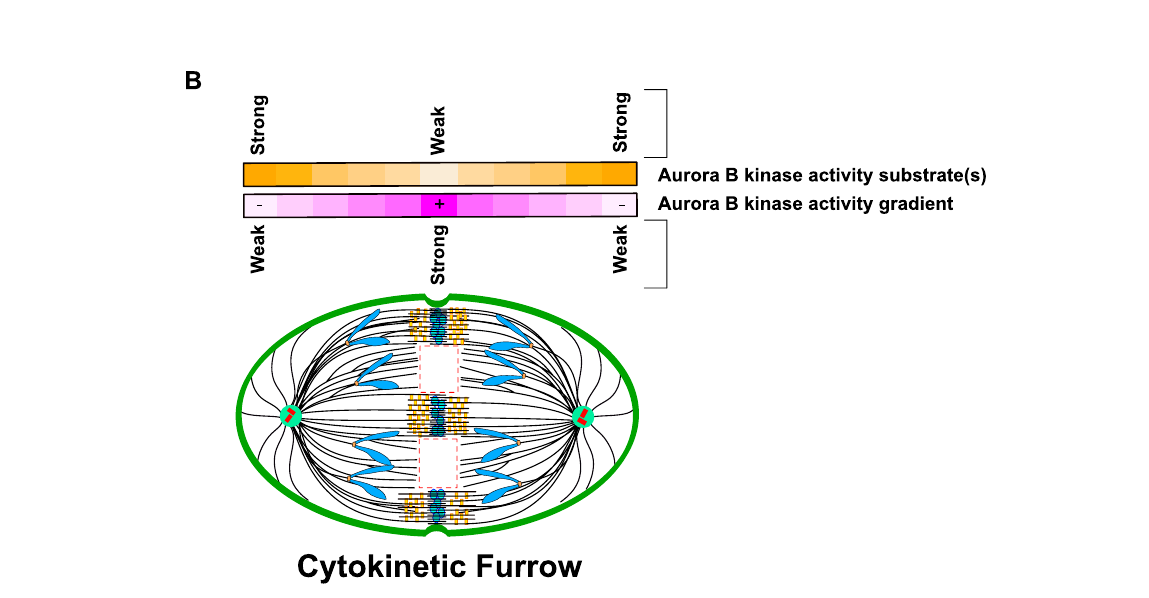
FIGURE 2 Intracellular gradients can transmit spatial information through relative binding af fi nities. (A) Bicoid protein gradients provide spatial information for anterior-posterior patterning of drosophila early embryonic syncitia. Bicoid mRNA is localized to the anterior pole of the Drosophila oocyte. Upon fertilization, the mRNA is translated generating that is high in the anterior pole. Bicoid is a transcription factor that binds a consensus sequence in regulatory elements of patterning genes. One such gene is orthodenticle which contains a poor binding site for bicoid and is only translated in the most anterior regions. In contrast hunchback has a better Bicoid binding site and has a broader transcriptional region in the anterior pole of the embryo. Notehunchbackisalsotranscribedintheposteriorpoleinabicoidindependentmannerbutthisisnotshownforclarity.FigureadaptedfromPorcherand Dostatni (2010). (B) Kinase-phosphatase activity gradients could generate spatial information by phosphorylating substrates in different regions of the gradient Purple line: CPC component Aurora B kinase generates a kinase gradient centered at the spindle midzone. The kinase activity is highest at the spindle midzone and decreases with the distance towards the spindle pole. Yellow line: Analogous to Bicoid protein activity, substrates with weak kinase consensus sitemay onlybephosphorylated inthecentralregionwheretheactivityishighestwhilebetterkinasesubstrateswouldbephosphorylatedina broader region of the gradient. Figure representation: Cell cortex, green; Spindle poles, green circle; Centrioles, red cylinders; Chromosome arms, blue; Kinetochores, orange rectangles; Microtubules, black lines; Central Spindlin complex, blue ovals; CPC, yellow rectangles; Microtubule free zones are highlighted within dash red lines. Abbreviation: CPC, Chromosomal Passenger